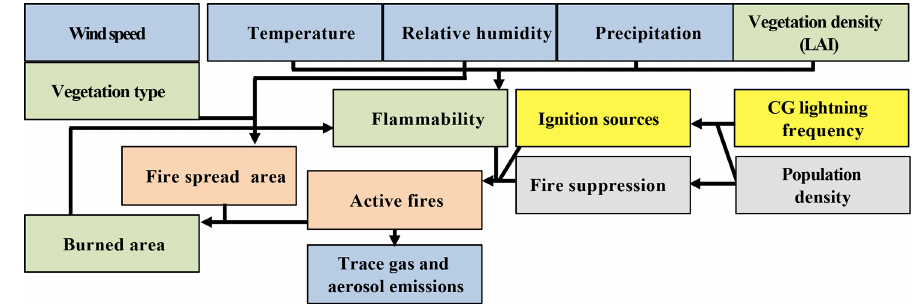
Figure 2. Structure of the fire parameterization of pyrE. Processes related to atmospheric properties are in blue, surface properties are in green, ignition and suppression are in yellow and gray, and fire properties are in red.